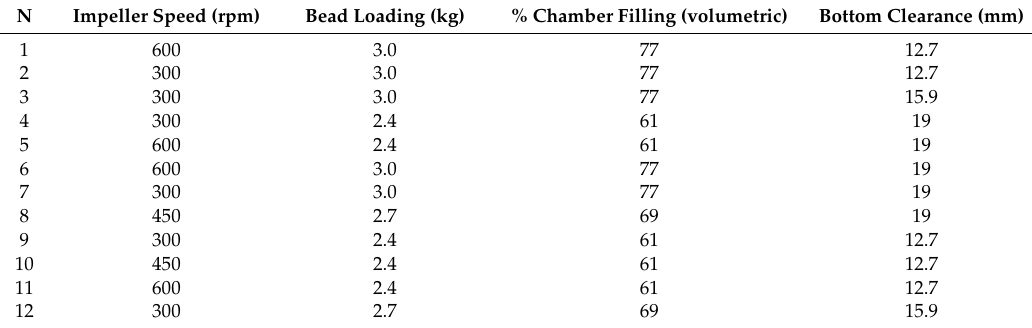
Table 2. Experimental conditions: impeller speed, bead loading and impeller bottom